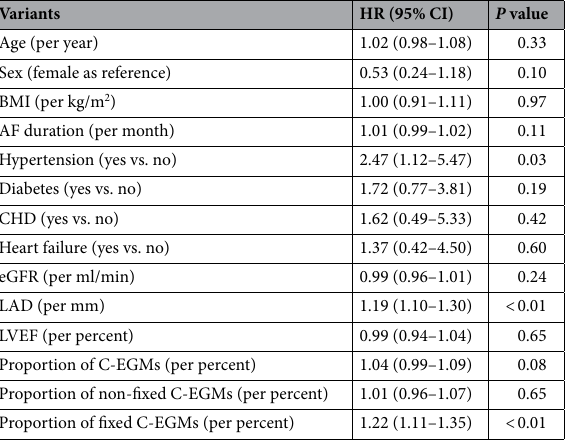
Table 3. Univariate Cox proportion-hazards regression. Based on data of AF patients not receiving fixed C-EGMs ablation. AF, atrial fibrillation; BMI, body mass index; CHD, coronary heart disease; eGFR, estimated glomerular filtration rate; LAD, left atrial dimension; LVEF, left ventricular ejection